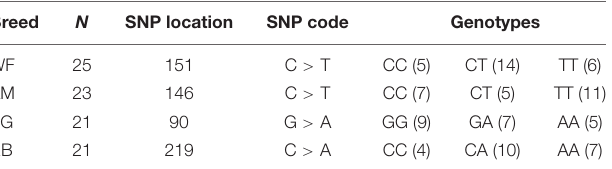
TABLE 4 | Single nucleotide polymorphisms (SNP) genotype within exon 1 of HSP 70 gene in four Nigerian Zebu cattle breeds.